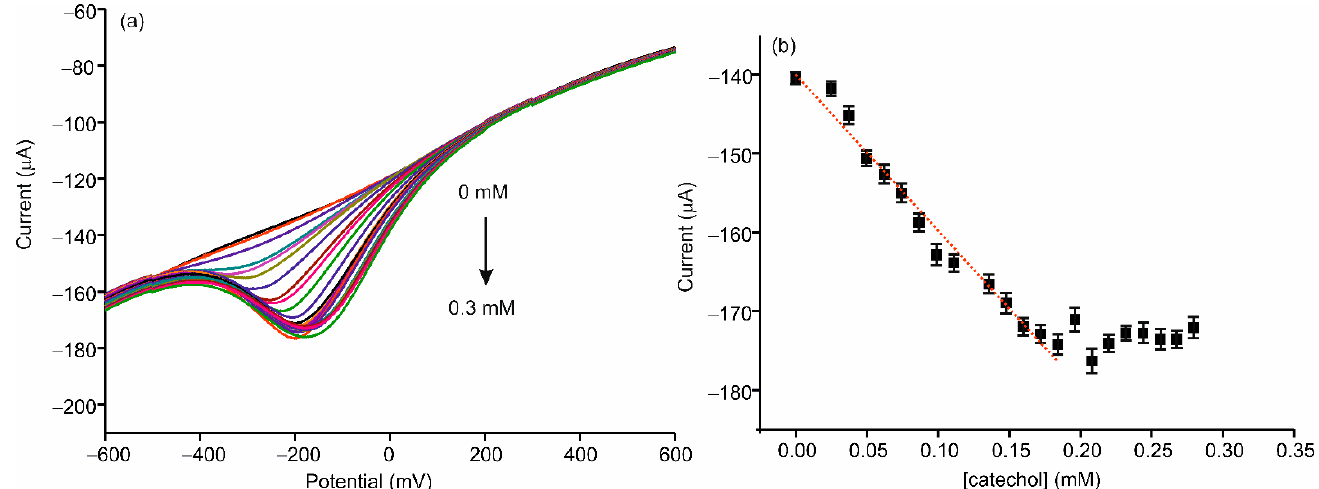
Figure 7. ( a ) Differential pulse voltammetry (DPV) response in 0.01 mol·L − 1 PBS, pH 7.0 to an increase concentration of catechol of an ITO-AgNWs–Tyr, ( b ) calibration curve of the response for increasing concentration of catechol. Table 1. Sensing parameters of different phenol oxidases modified electrodes toward